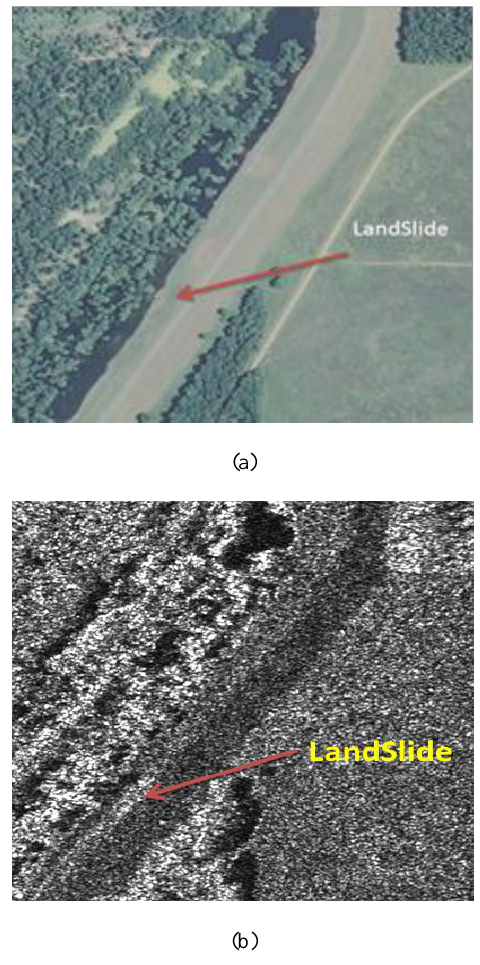
Figure 1. (a) a part of the study area; (b) the corresponding TerraSAR-X data for Sept 04, 2010.